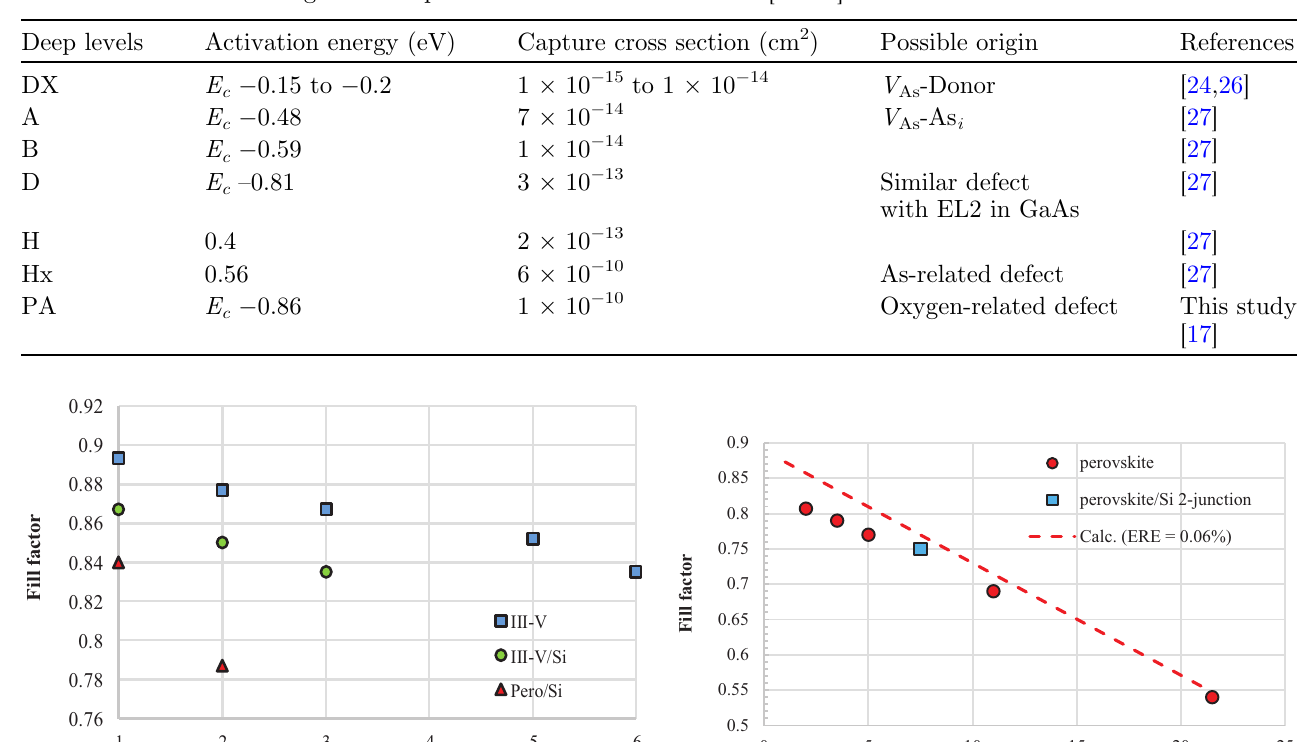
Fig. 7. Changes in external radiative ef fi ciency ERE for AlGaInP top cell and AlGaAs 2nd layer cell of 6-junction solar cell [16] and MBE-grown AlGaAs single-junction solar cell [18] as a function of non-radiative recombination centers estimated by using equations (11) – (14). Table 2. Activation energies and capture cross sections in AlGaAs [25 – 27] and our result.